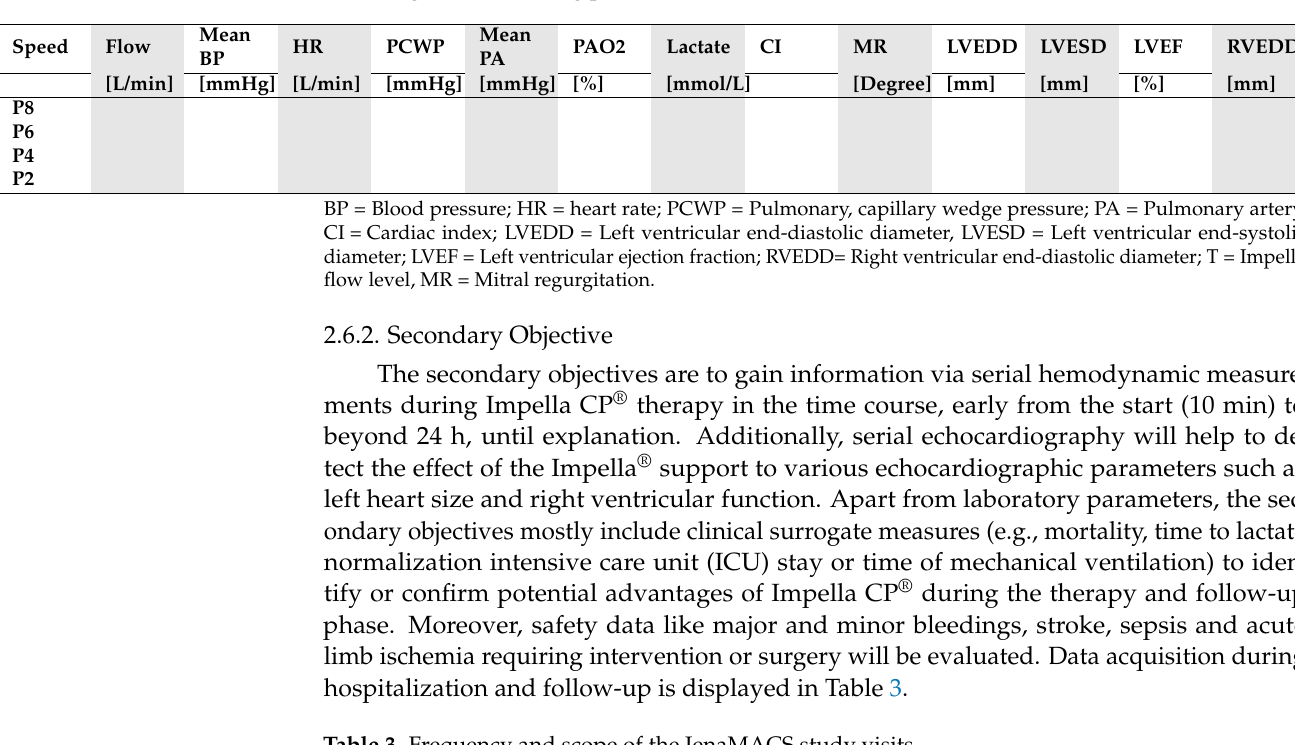
Table 2. Ramp Test protocol: A ramp test will be performed 24 h after Impella CP ® implantation according to the following protocol.